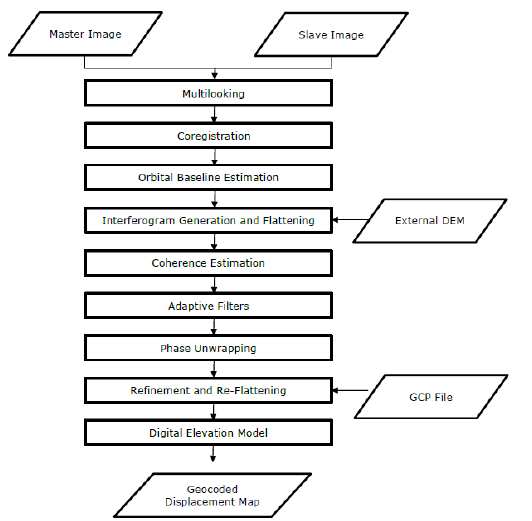
Figure 4: Glacier velocity estimation using DInSAR data (adopted from Thakur et al., 2016).